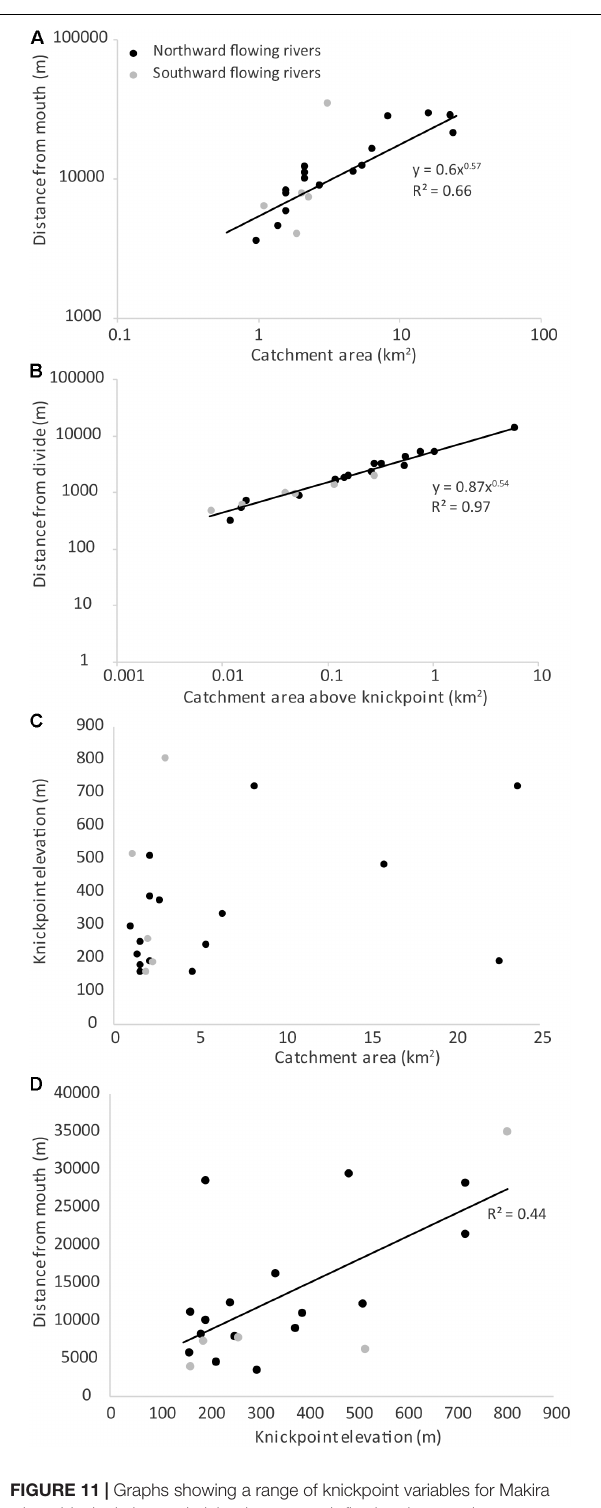
FIGURE 11 | Graphs showing a range of knickpoint variables for Makira where black circles are knickpoints on north flowing rivers and gray are on south flowing rivers. (A) Distance from mouth against total catchment area, (B) Distance from divide against catchment area above the knickpoint, (C) Knickpoint elevation (above sea-level) against total catchment area and (D) distance from mouth against knickpoint